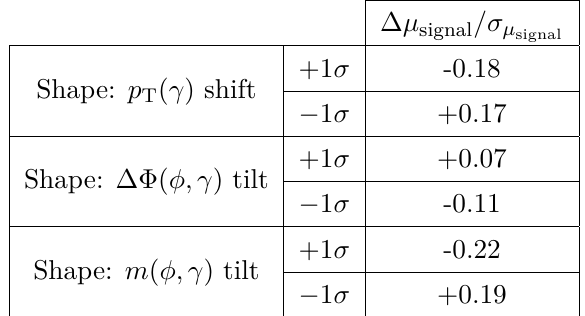
Table 4 . The change in the fitted signal strength, relative to its uncertainty, is shown for the case where the corresponding nuisance parameter is fixed to its best fit value plus or minus its corresponding